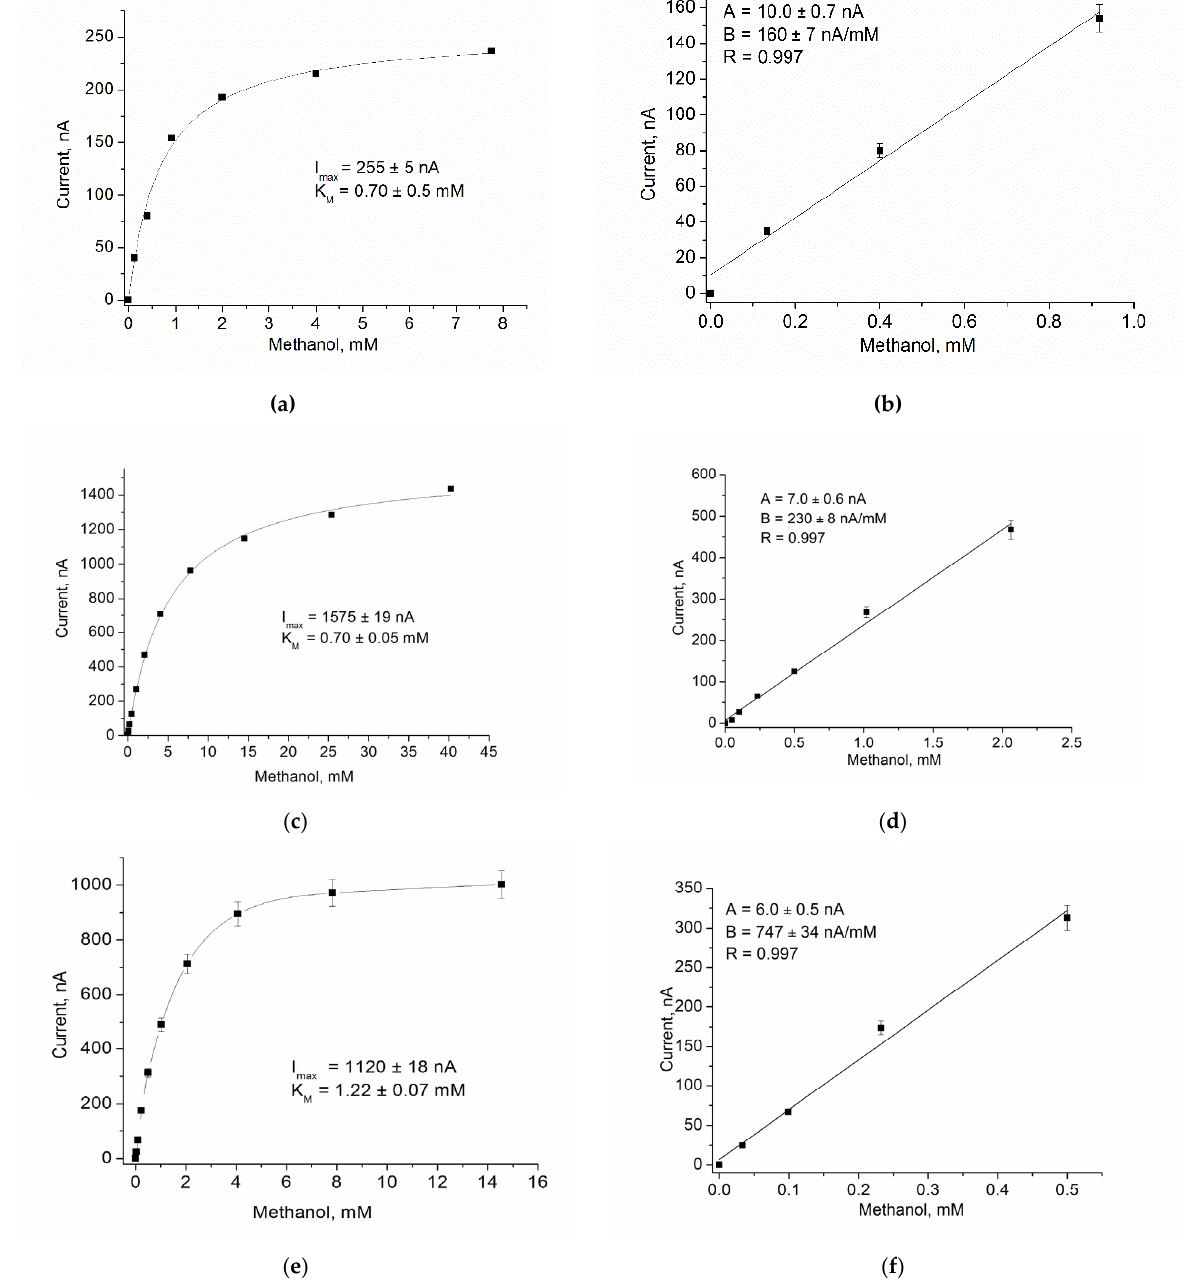
Figure 6. Amperometric characteristics of the AO/PO/GE ( a , b ), the AO/nCuCe/GE ( c , d ), and the AO/nCuCe/pAu/GE ( e , f ): ( a , c , e ) dependence of amperometric signal on concentration of methanol; ( b , d , f ) calibration graphs for methanol determination. Conditions: working potential –50 mV vs. Ag/AgCl/3 M KCl in 50 mM PB, pH 7.5.